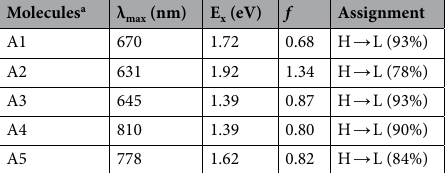
Table 3. The calculated UV results of A1–A5 at TD-DFT/B3LYP 6-31G(d,p) in gas phase.